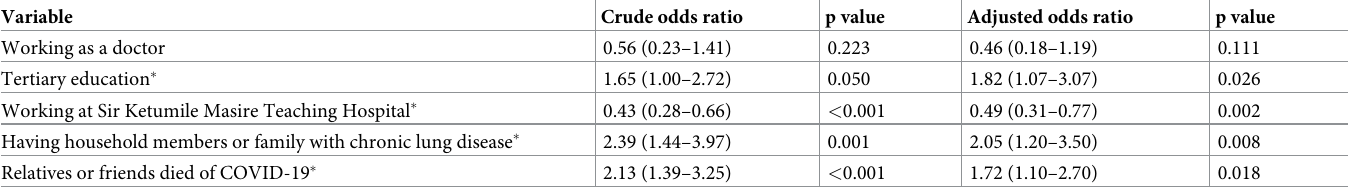
Table 6. Predictors of anxiety among frontline healthcare workers in Gaborone.